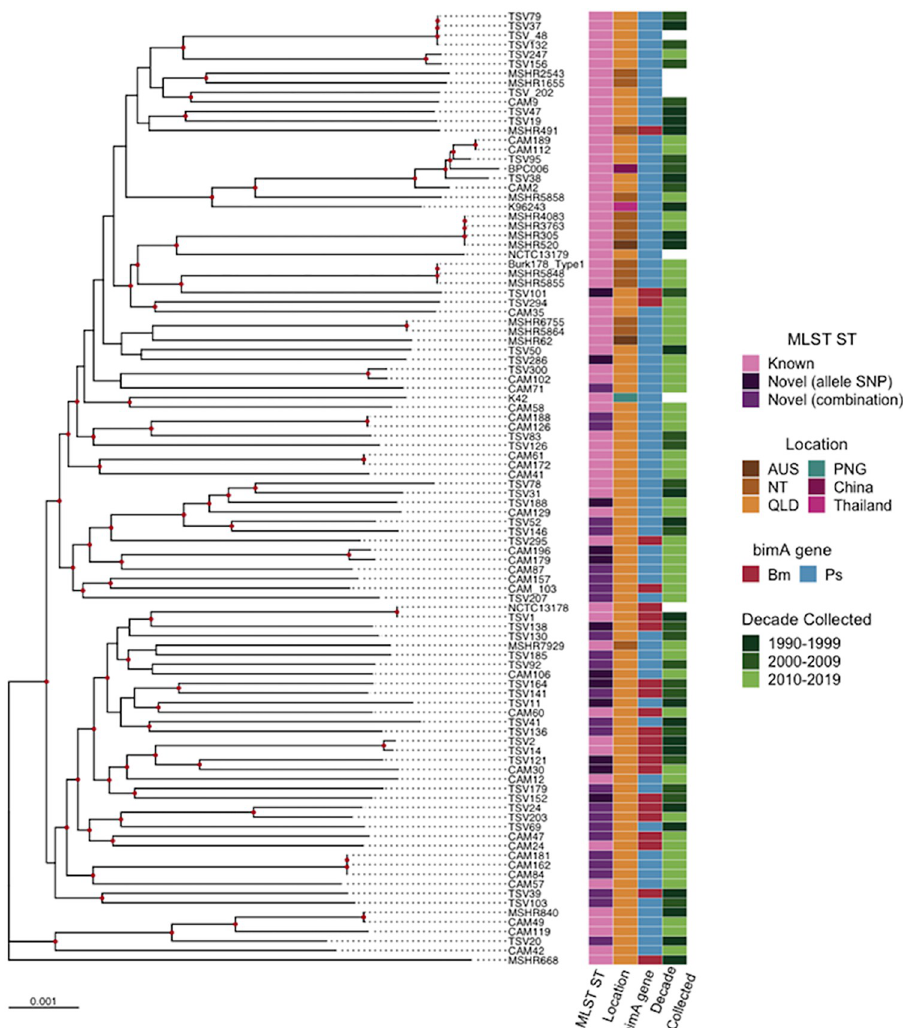
Fig 3. Maximum likelihood phylogenomic tree of Australian B . pseudomallei isolates, rooted to reference MSHR668. Bootstrap support � 80 is shown at nodes in red and reference genomes are labelled with strain name stated in NCBI. Tree was built using IQtree 100 genomes and a 4,950,632 bp alignment generated from parSNP.